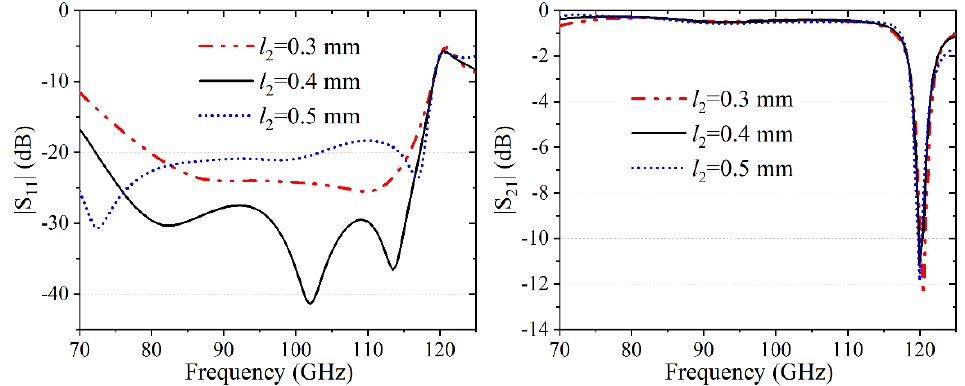
Figure 7. The simulated S-parameters with different lengths of parasitic patch.